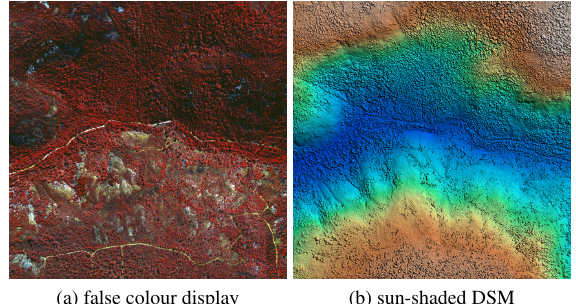
Figure 5. The region used to guide parameter choices for the hilly terrain. Dimensions: 1 km by 1 km . Grey colours correspond to high elevations ( ∼ 270 m ), cool colours correspond to low eleva- tions (blue ∼ 63 m ).